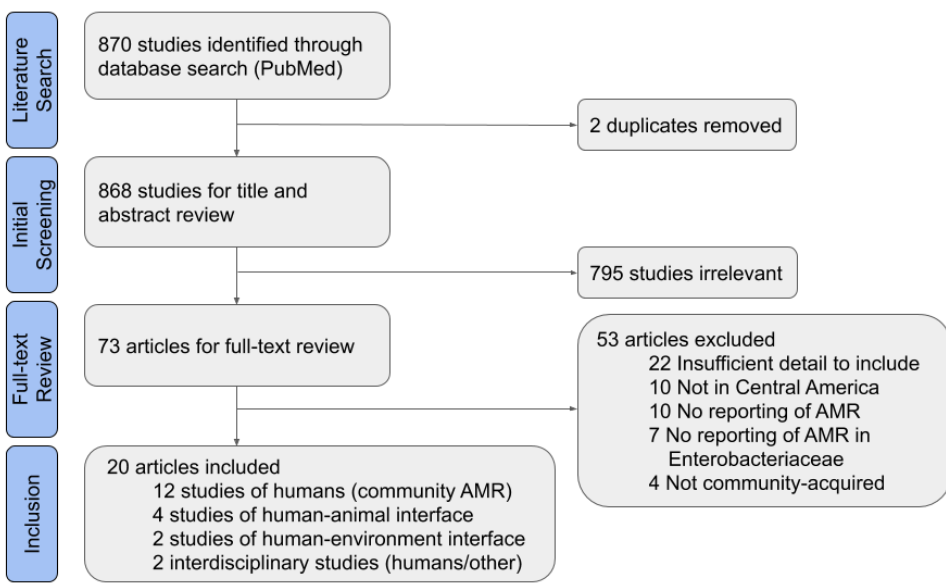
Figure 1. Preferred Reporting Items for Systematic Reviews and Meta-Analyses (PRISMA) Flow Diagram for systematic literature review.